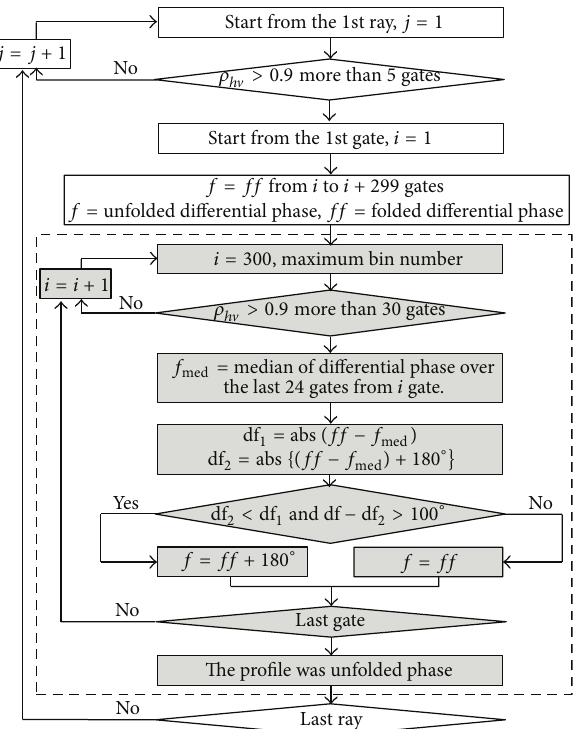
Figure 2: Flowchart of differential phase shift-unfolding algorithm.